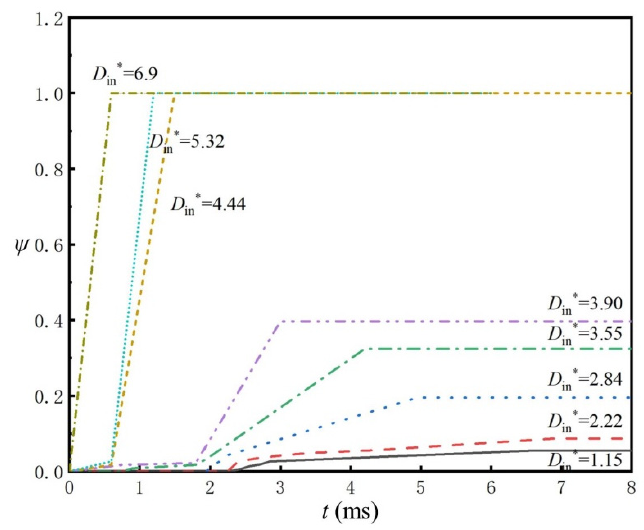
Figure 11. The variation in opening.